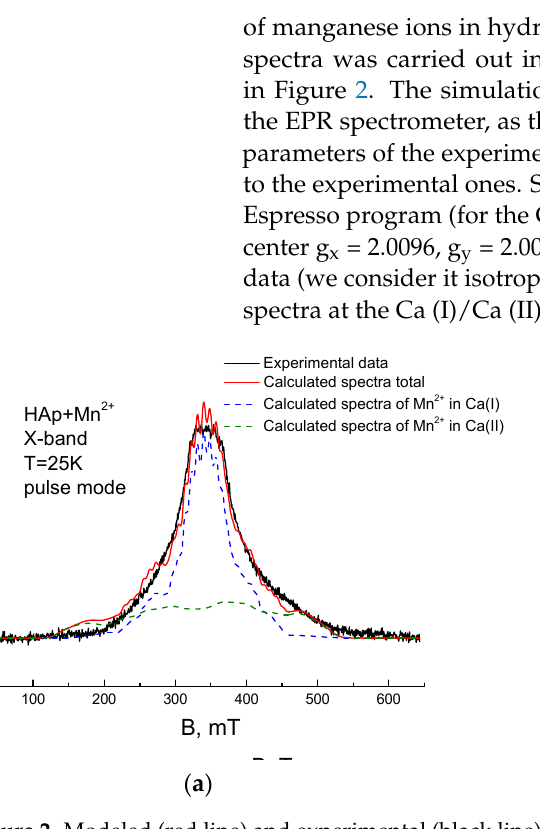
Figure 2. Modeled (red line) and experimental (black line) EPR spectra of Mn 2+ ions in the X-range ( a ) and in the W-range ( b ) in a hydroxyapatite sample in the pulse mode.